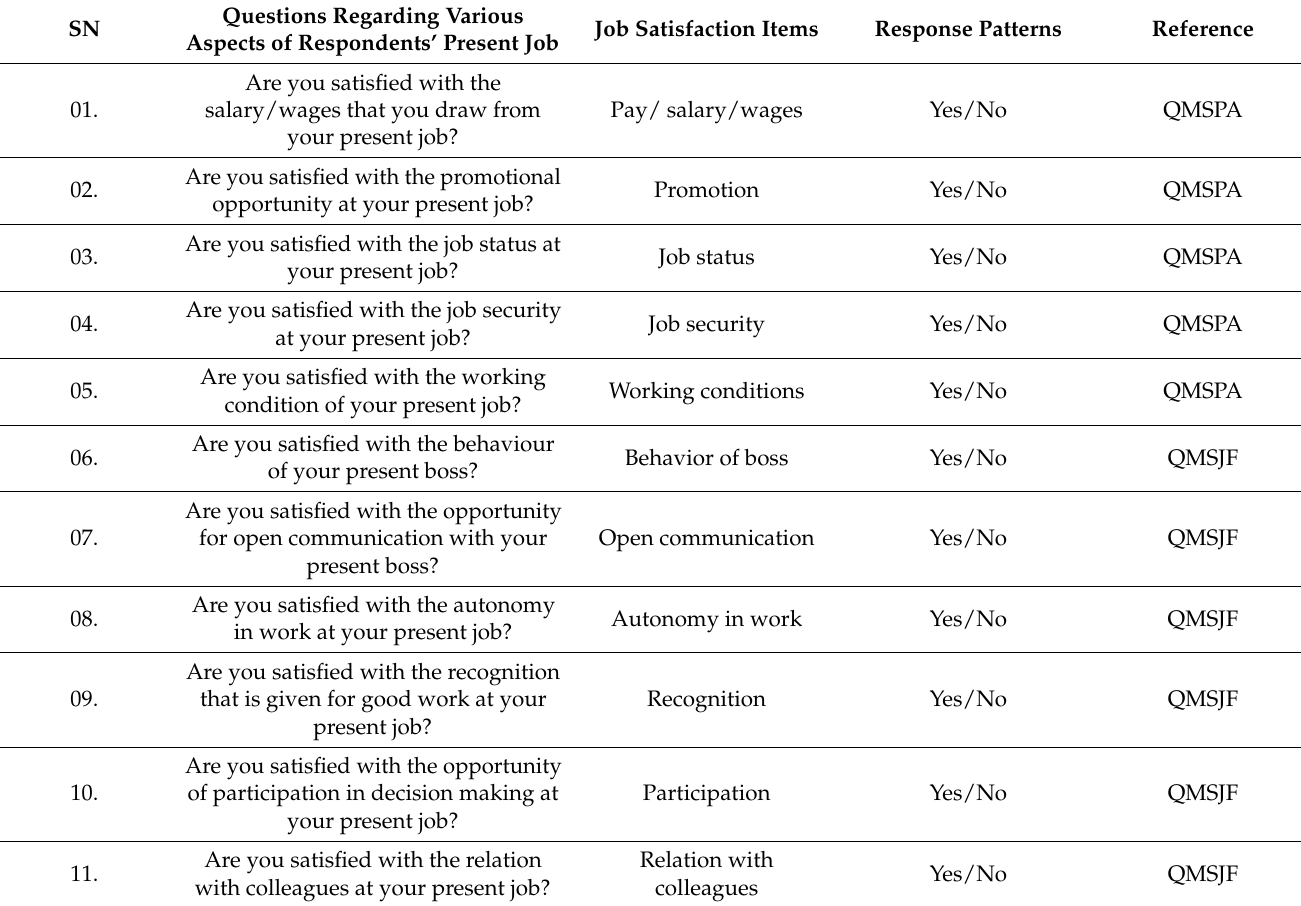
Table A2. Overview of Professional Aspects of Job